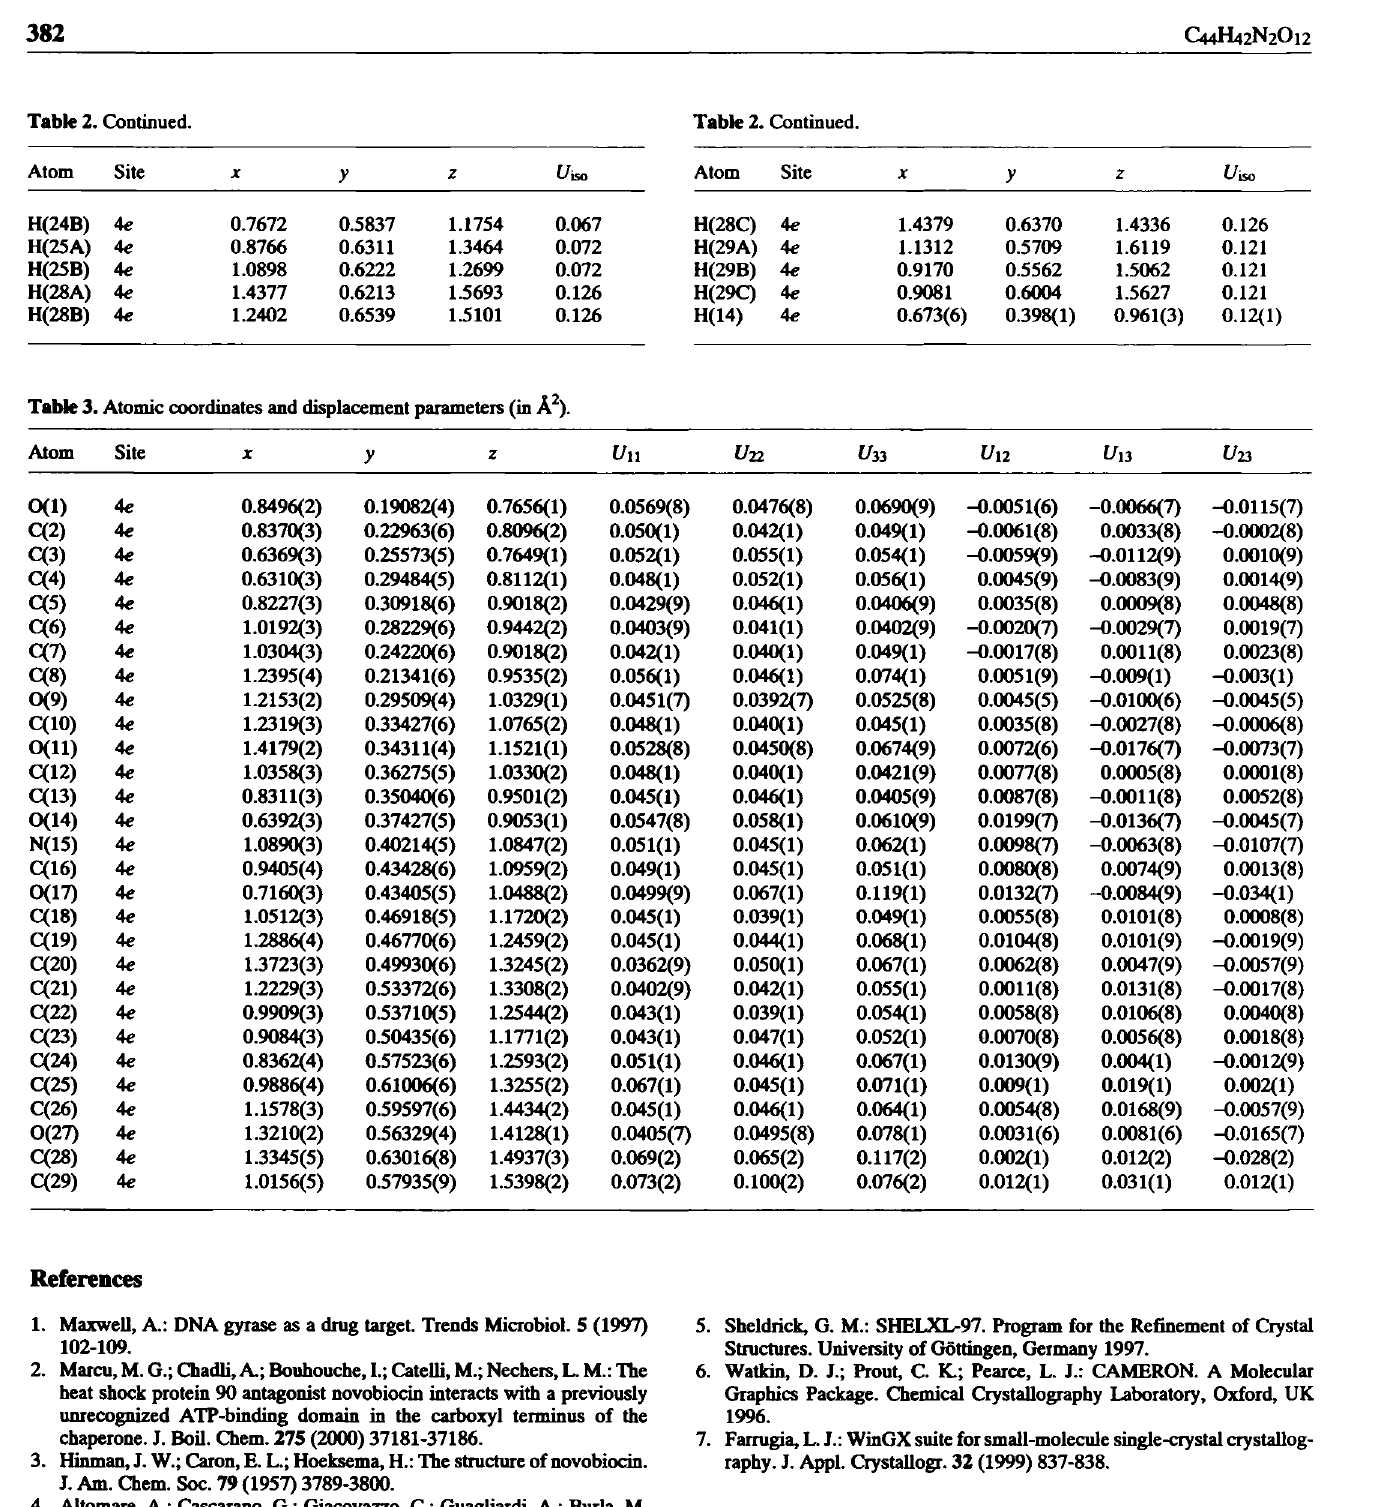
Table 3. Atomic coordinates and displacement parameters (in A 2